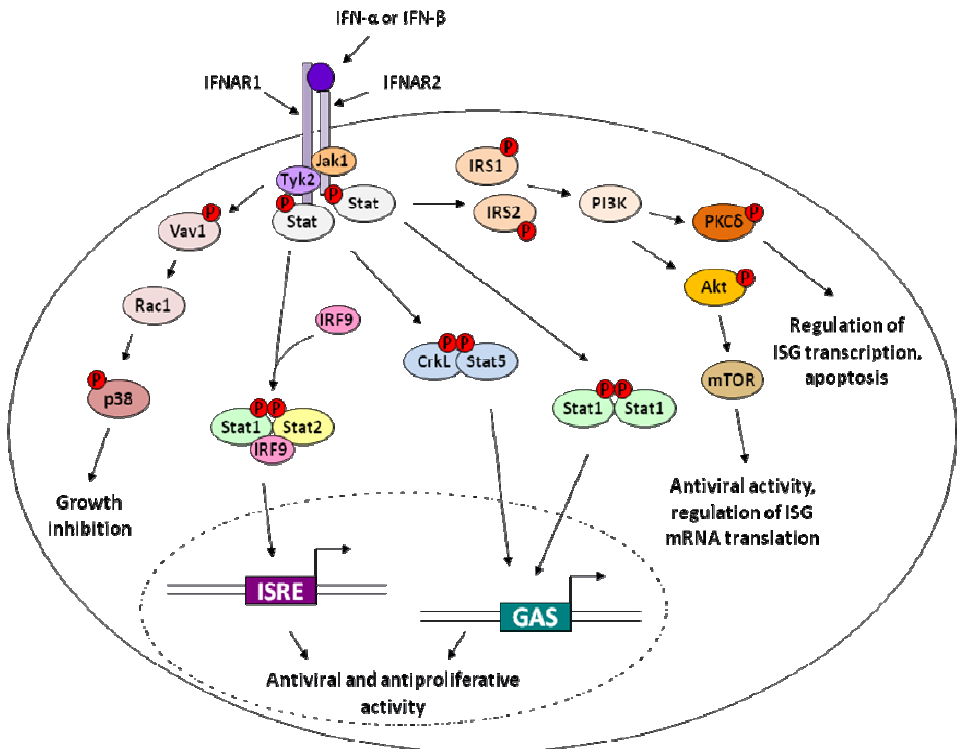
Figure 1. Type I IFN Signaling. Type-I IFNs bind to a heterodimer composed of the transmembrane receptor subunits IFNAR1 and IFNAR2, which results in activation of the receptor-associated kinases Jak1 and Tyk2. In the canonical signaling pathway, the cytoplasmic signal transducers and activator of transcription (Stat) proteins are recruited to the receptor docking sites, phosphorylated, and dimerize to form the active transcription factors ISGF3 (Interferon stimulated gene factor 3), composed of phosphorylated Stat 1 and Stat2, and IRF9 (p48/ISGF3 γ ), and AAF/GAF (alpha activation factor/gamma activation factor), which is composed of two phosphorylated subunits of Stat1. These induce transcription of hundreds of interferon-stimulated genes (ISGs). IFN treatment also leads to induction of other non-canonical signaling pathways, including those involving p38 MAPK, Akt, and Crk. Upstream signaling from the IFNR complex leads to p38 phosphorylation, which modulates IFN activity and leads to growth inhibition of cells. CrkL and CrkII are tyrosine phosphorylated by Tyk2 after IFN treatment, and CrkL can also form transcription factor complexes with phosphorylated Stat5. Signaling pathways downstream of PI3K, involving Akt and mTOR, or PKC δ , are also important in mediating the biological activities of